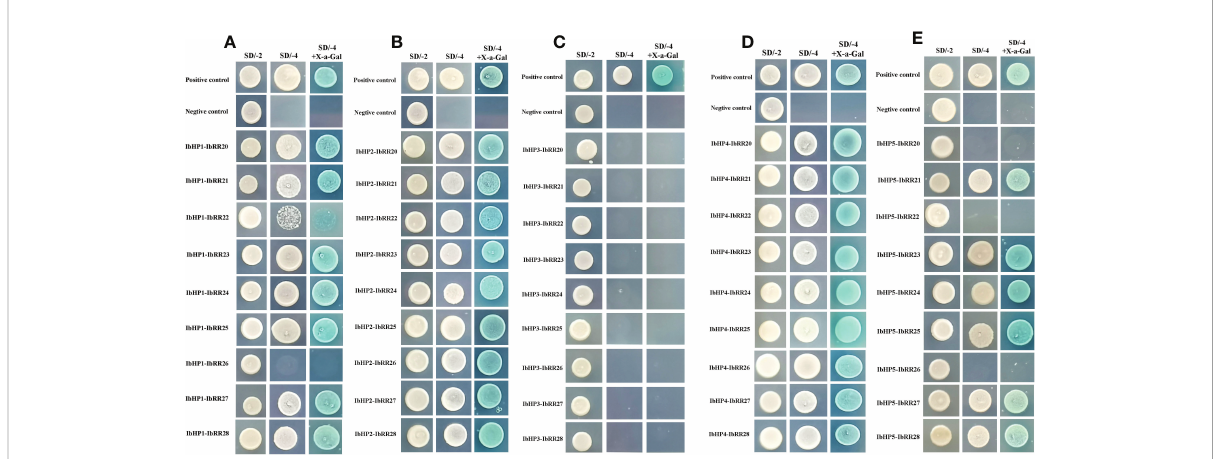
FIGURE 9 Protein-protein interaction studies among IbHP1~IbHP5 and IbRR20~IbRR28 with yeast-two hybrid assays. (A) Interactions between IbHP1 and IbRR20~IbRR28, (B) Interactions between IbHP2 and IbRR20~IbRR28, (C) Interactions between IbHP3 and IbRR20~IbRR28, (D) Interactions between IbHP4 and IbRR20~IbRR28, (E) Interactions between IbHP5 and IbRR20~IbRR28.